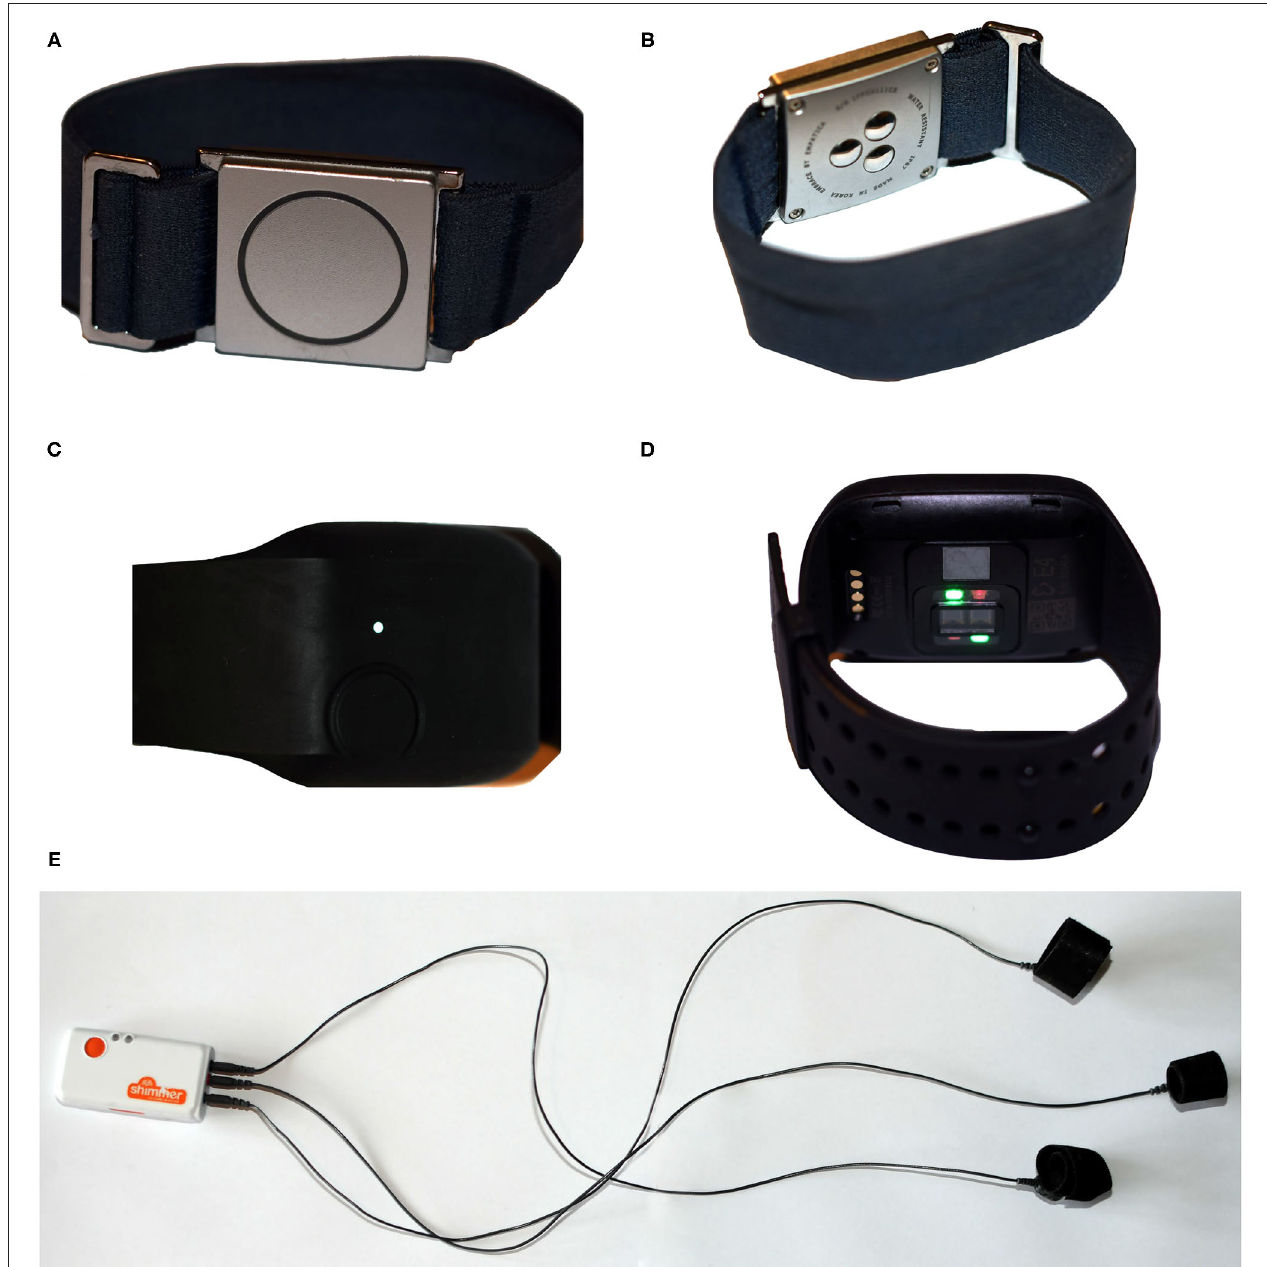
FIGURE 1 | (A,B) A wrist worn commercially available seizure detector with integrated ACC and EDA sensor, (B) displays three electrodes for EDA measure that are in contact with the skin. (C,D) A wrist worn commercially available sensing device with integrated ACC, EDA, and PPG sensor. (D) Displays the PPG sensor that is in contact with the skin. (E) A wired galvanic skin response (EDA) sensing solution, with velcro fabric finger cuffs and a small receiver unit that attaches to the wrist.